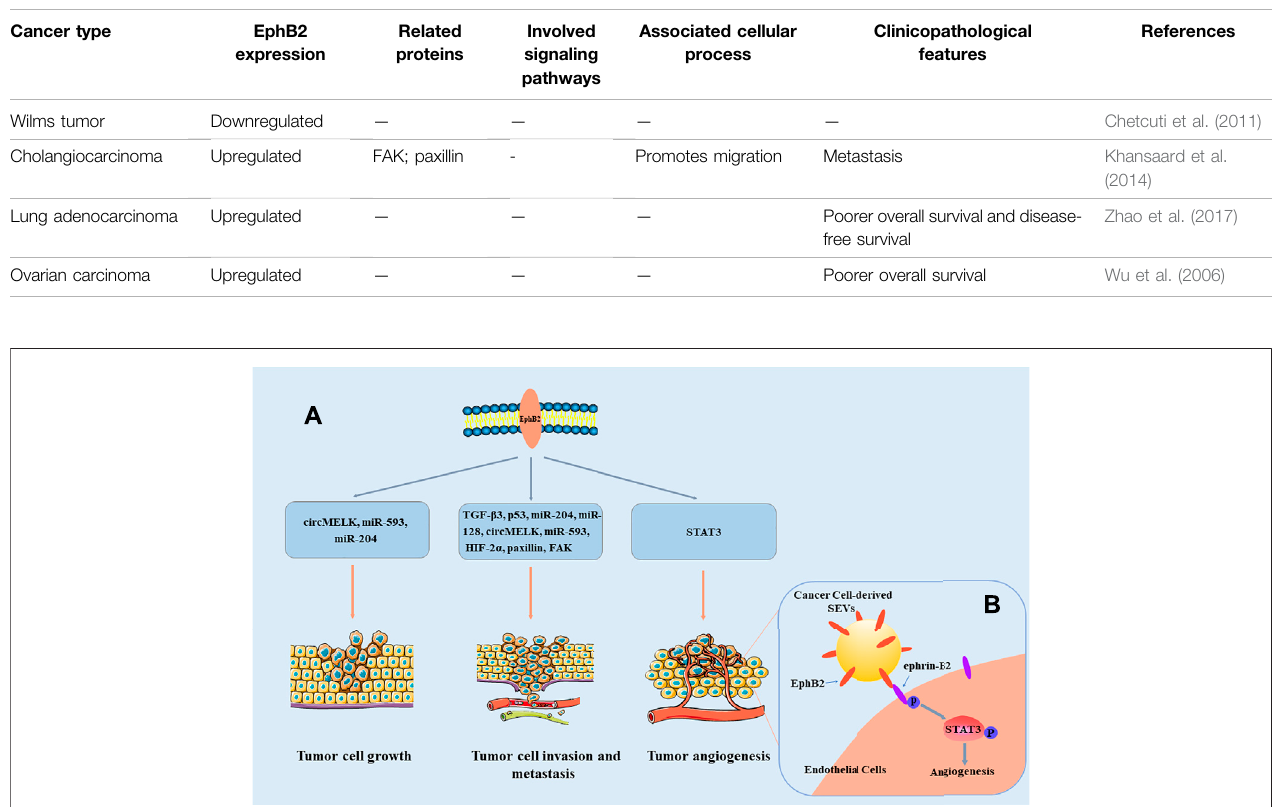
TABLE 1 | ( Continued ) The expression levels and functions of EphB2 in different